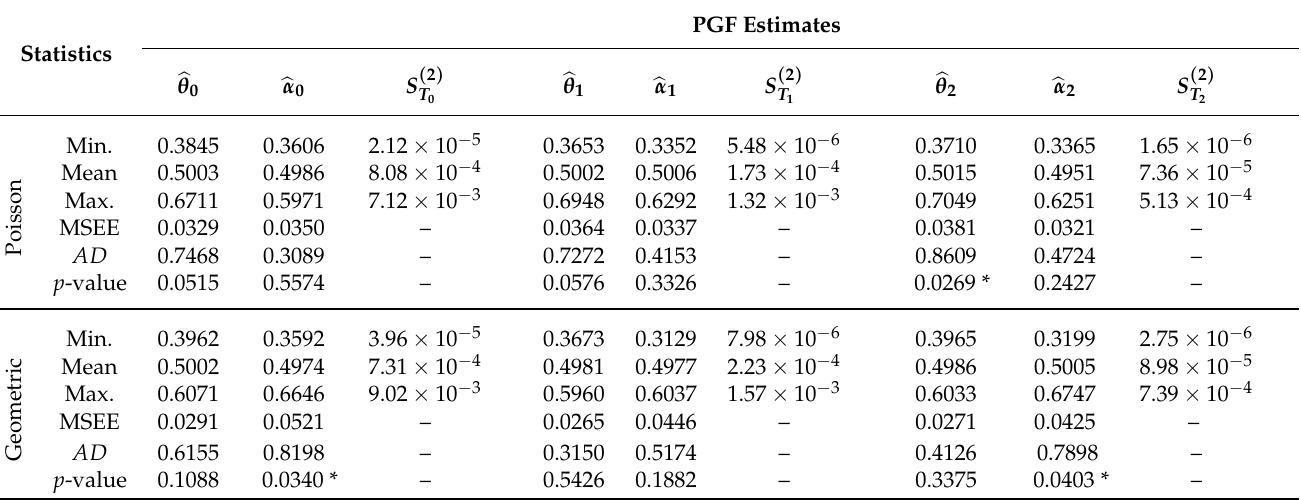
Table 3. Estimated parameter values of the INAR(1) process ( X t ) with Poisson and geometric innovations. ( True parameters’ values are θ = α =